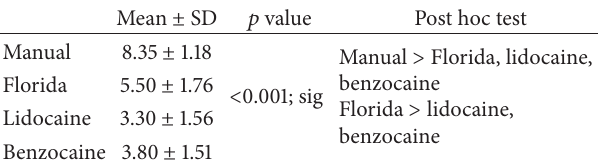
Table 2: Intergroup comparison of VAS